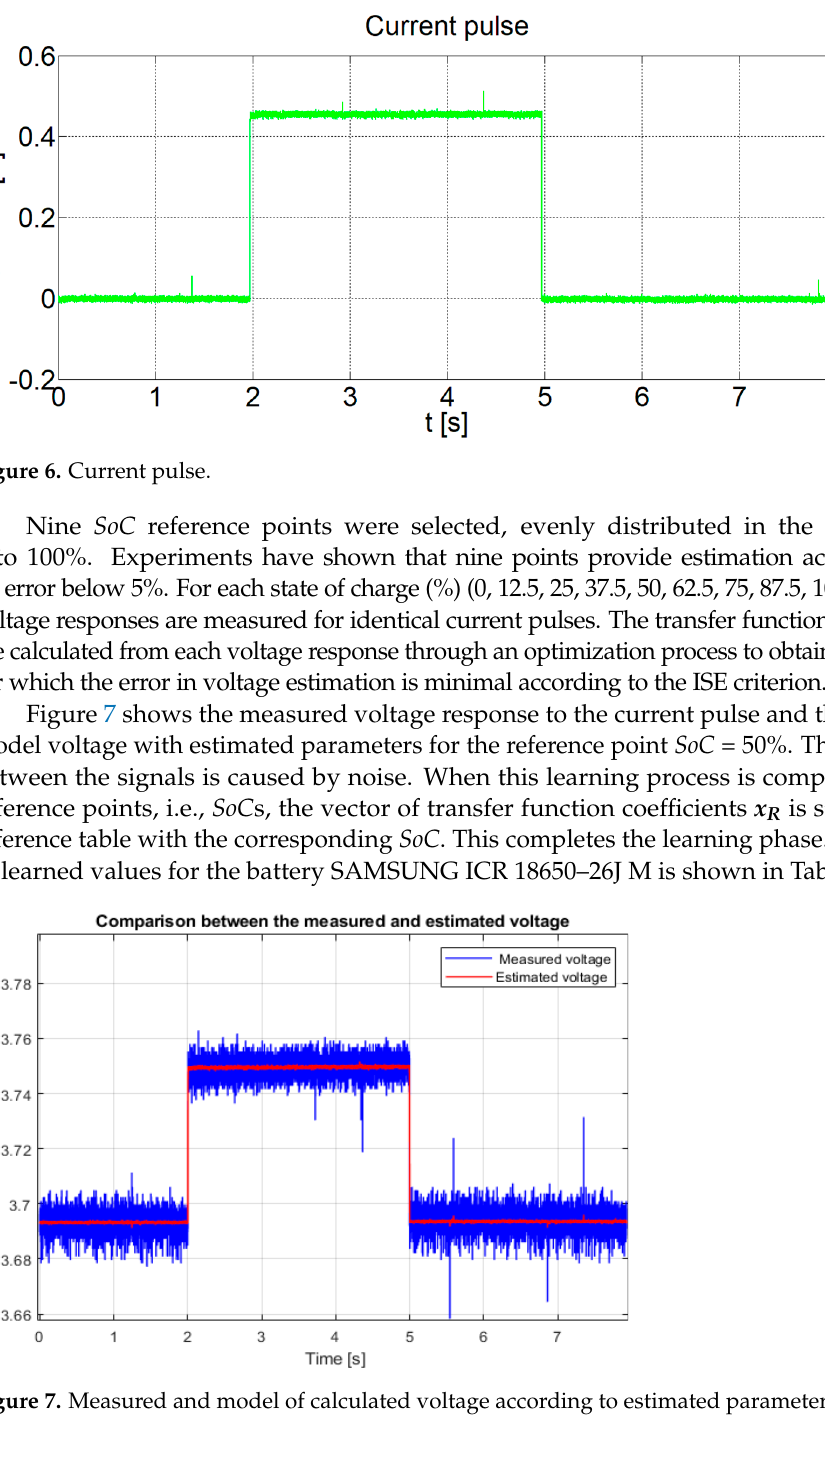
Figure 5. Experimental setup.